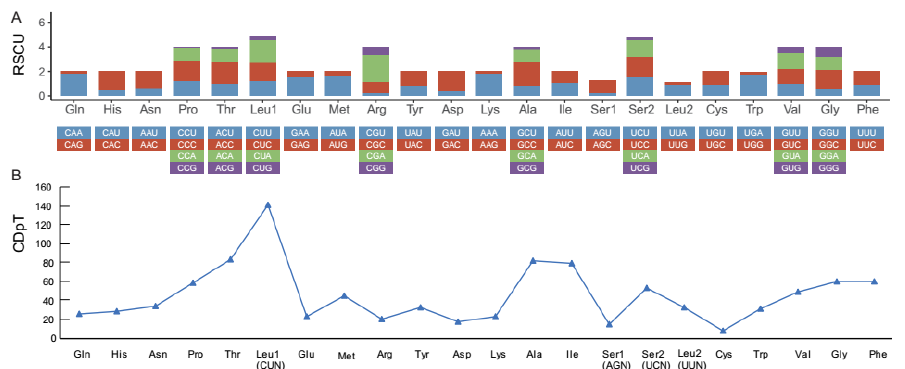
Figure 2. The relative synonymous codon usage (RSCU) ( A ) and codon distribution ( B ) of PCGs in the mitogenomes of selected breeds of M. albus . CDpT, codons per thousand codons.